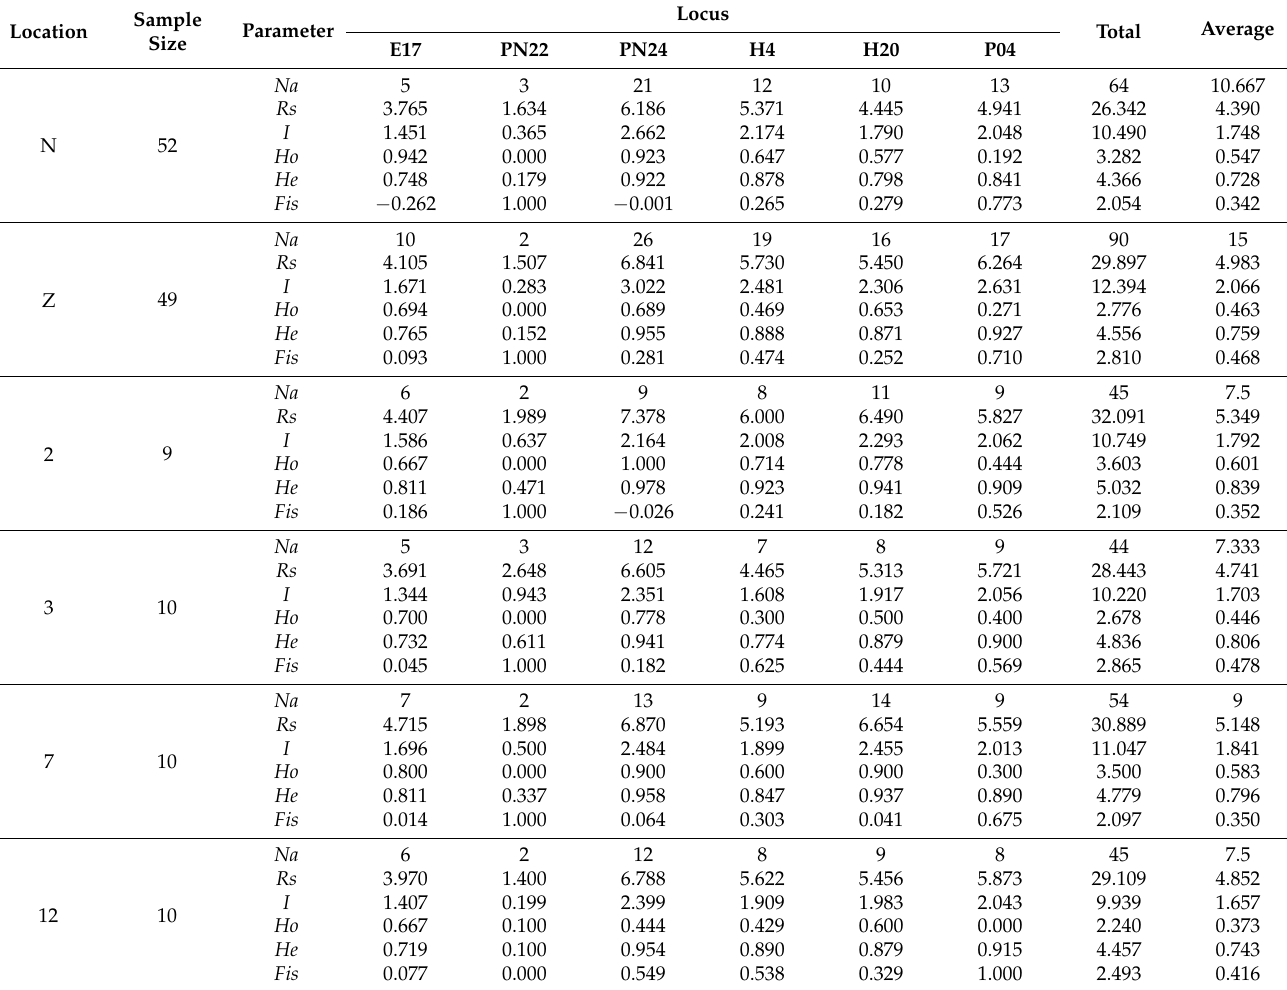
Table 3. Main polymorphic parameters for six microsatellite loci utilized in this